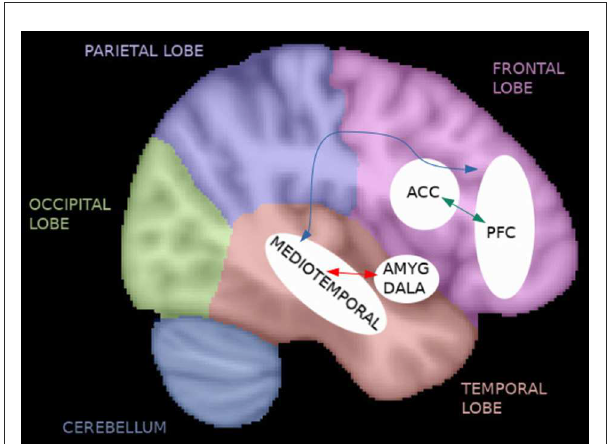
FIGURE3 Functional connectivity in TRS. The reviewed studies noted frontal hypoconnectivity before the initiation of treatment with clozapine (CLZ) or riluzole (e.g., anterior cingulate cortex [ACC] and prefrontal cortex [PFC]), an increase in frontal connectivity after riluzole treatment (green arrow), fronto-temporal hypoconnectivity that may be specific for non-responders (blue arrow), widespread abnormal functional connectivity during mixed treatments, and electroconvulsive therapy (ECT)-induced effects specifically on the limbic system (red